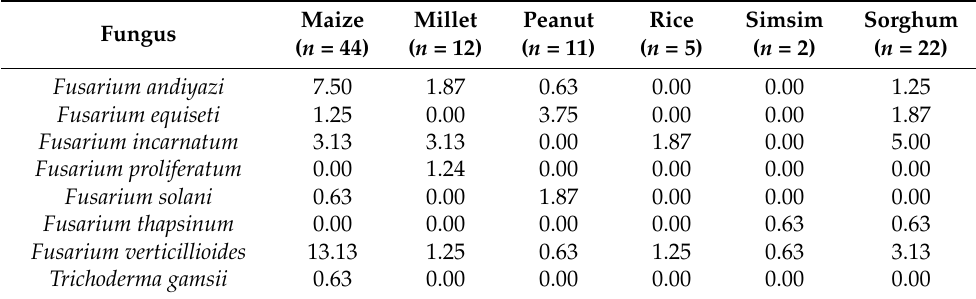
Maize Millet Peanut Rice Simsim Sorghum ( n = 44) ( n = 12) ( n = 11) ( n = 5) ( n = 2) ( n = 22)